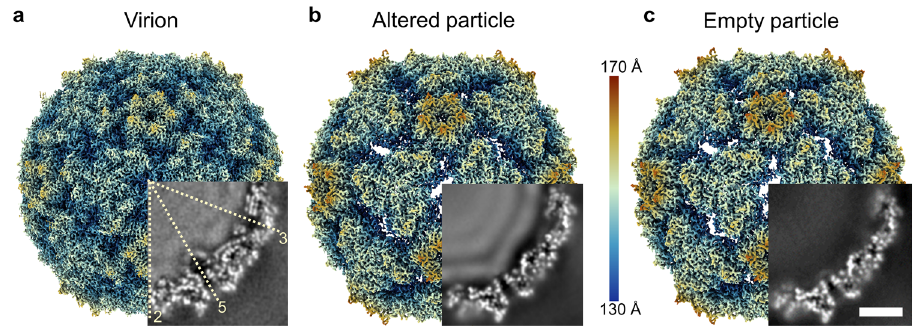
Fig. 1 Structure of CV-A6 virion, altered, and empty particle. Cryo-electron density map of CV-A6 virion ( a ), altered particle ( b ), and empty particle ( c ), viewed along the twofold icosahedral symmetry axis, coloured according to distance from centre of particle. The insets show central slices through the particle interior (central slice, thickness 5 Å). Virion and altered particle contain genomic RNA ( a , b ). Positions of icosahedral symmetry axes are indicated by dashed lines in a . Scale bar 5